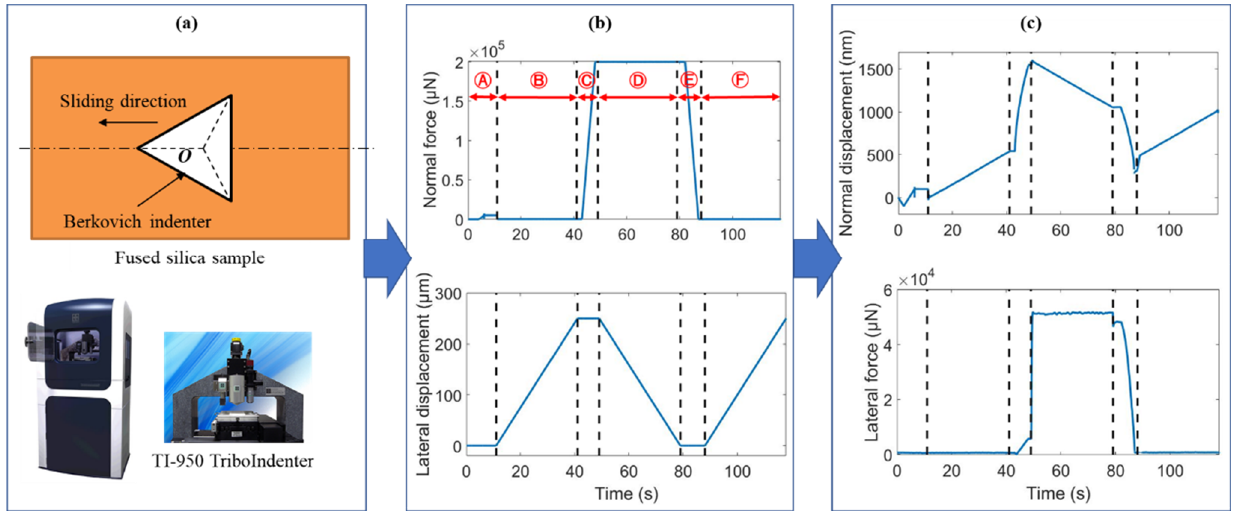
Figure 1. ( a ) Schematic diagram of edge-forward Berkovich scratching, ( b ) the applied normal force and lateral displacement for the normal load of 200 mN, and ( c ) the resulting normal displacement and lateral force.